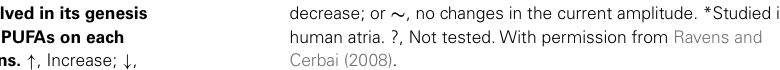
decrease; or ∼ , no changes in the current amplitude. *Studied in human atria. ?, Not tested.With permission from Ravens and Cerbai